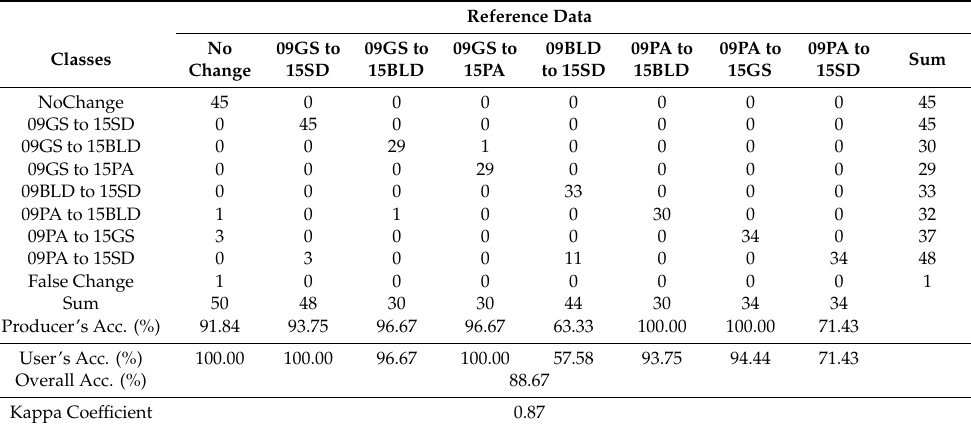
Table 12. The classification accuracies of changes in Method